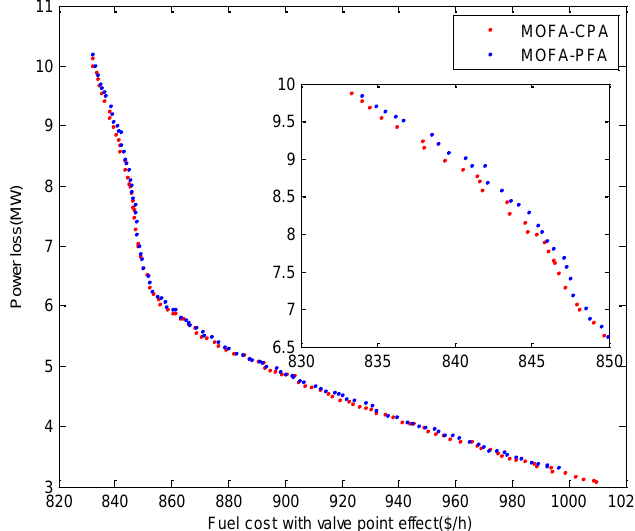
Figure 2. PFs obtained by MOFA-CPA and MOFA-PFA for Case 2.